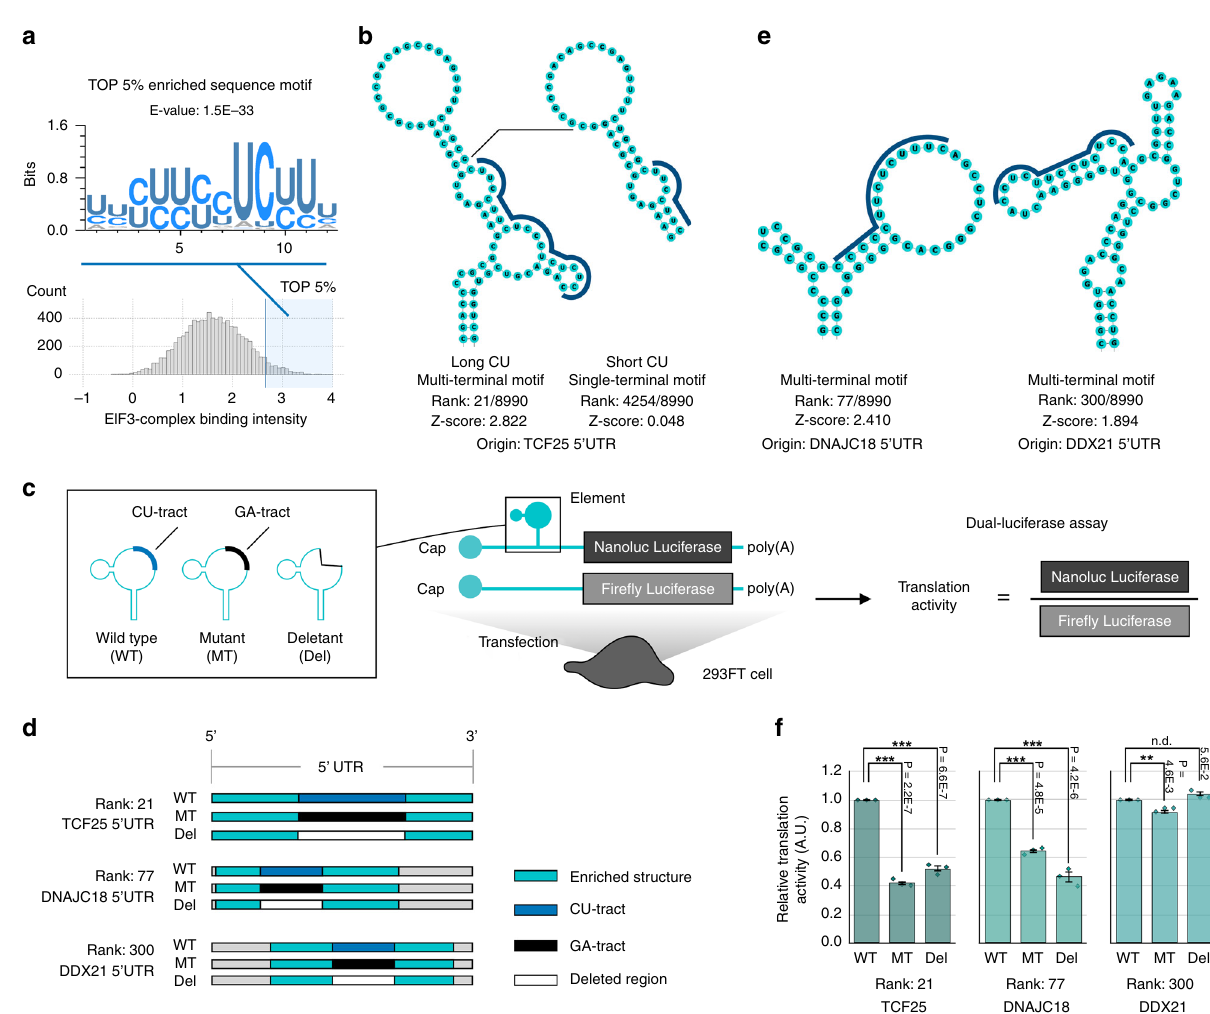
Fig. 7 FOREST identi fi es translational regulatory elements by pro fi ling the binding properties of the EIF3 complex. a An enriched sequence motif determined by MEME analysis of the population with the top 5% of cellular EIF3-complex binding intensities. b Two RNA structures derived from the 5 ′ UTR of TCF25. c A dual-luciferase reporter assay using the designed 5 ′ UTR of the identi fi ed candidates. A reporter mRNA encoding Nanoluc Luciferase was transfected into 293FT cells with Fire fl y Luciferase mRNA as the internal control. The CU-tracts of the RNA structures were redesigned as follows: mutants (MT) were designed by converting CU to GA sequences, and deletants (Del) were designed by deleting CU sequences. d Schematic of each 5 ′ UTR of the reporter mRNAs. Reporter mRNAs contained the analyzed RNA structures with their whole 5 ′ UTR sequences. The analyzed structures, the CU- tracts, and the converted GA-tracts are represented as turquoise, blue, and black regions, respectively. e Representative CU-rich RNA structures. According to the Z -scores, the DNAJC18-derived structure and the DDX21-derived structure have a high and medium af fi nity for the EIF3 complex, respectively. f Translational activity analysis. The intensities were normalized to those of each wild type. Error bars indicate means ± s.e.m. The experiments were performed with three biological replicates, each with two technical replicates. The p values were determined by two-tailed Dunnett ’ s test. *** p < 0.001, ** p < 0.01, * p < 0.05. n.d. indicates no signi fi cant difference. Each “ ◇ ” indicates a data point. Source data are provided as a Source Data fi